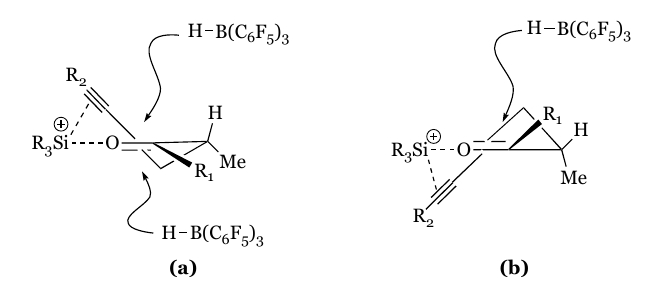
Figure 30. Half-chair conformations explaining syn -selectivity: ( a ) relatively small R 1 groups do not distort the carbonyl conformer framework; ( b ) increasing the size of R 1 causes a conformational change of Me group favoring attack from the top, increasing syn selectivity.